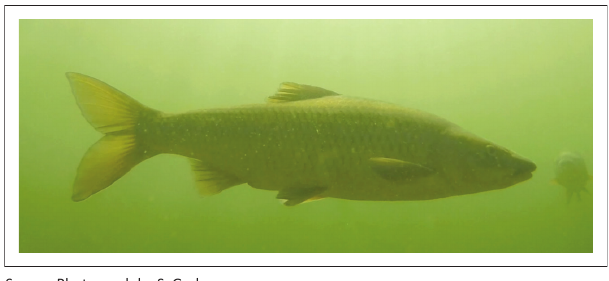
FIGURE 1: An adult (approximate length 50 cm) Barbus andrewi at Site 5 in the upper Hex River during the 2015